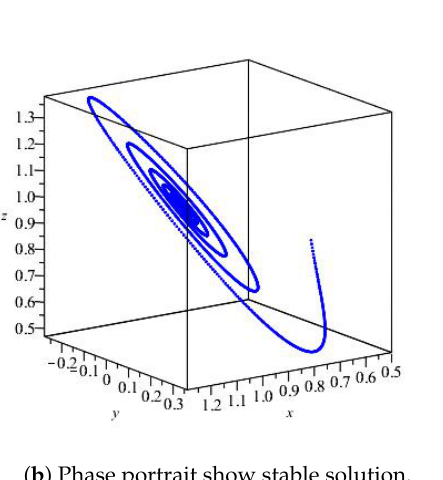
( b ) Phase portrait show stable solution. Figure 2. Solution for system Equation (6) when α = 0.9, β = 1, σ = 0.736. Table 2. The stability condition for the system under certain range of β when α cr =